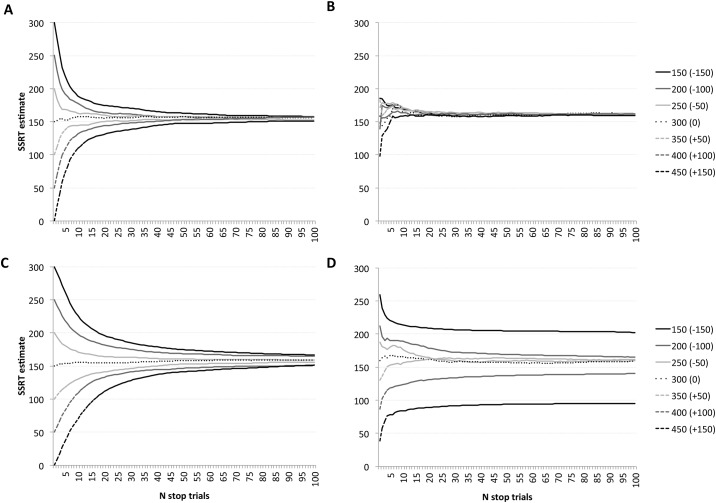
Mean simulated SSRT estimates across 100 stop trials.Simulations used adaptive staircases controlled by stepwise adjustment (A and C) or the Ψ method (B and D), in which the true stop RT was fixed at 150 ms. For stepwise adjustment, the numbers in the legend refer to the starting point for the SSD estimate (and the difference between the starting point and the actual difference between go RT and stop RT). The steps taken on each trial were either 50 ms (A) or 10 ms (C). For Ψ adjustment, the numbers in the legend refer to the mid-point of the hypothesis space for the alpha parameter (and the difference between this midpoint and the actual difference between go RT and stop RT). The range of the hypothesis space alpha parameter of the p(i) function was set at either 500ms (B) so that all critical SSDs fell within the hypothesis space or 200ms (D) so that the more extreme critical SSDs fell outside the hypothesis space.